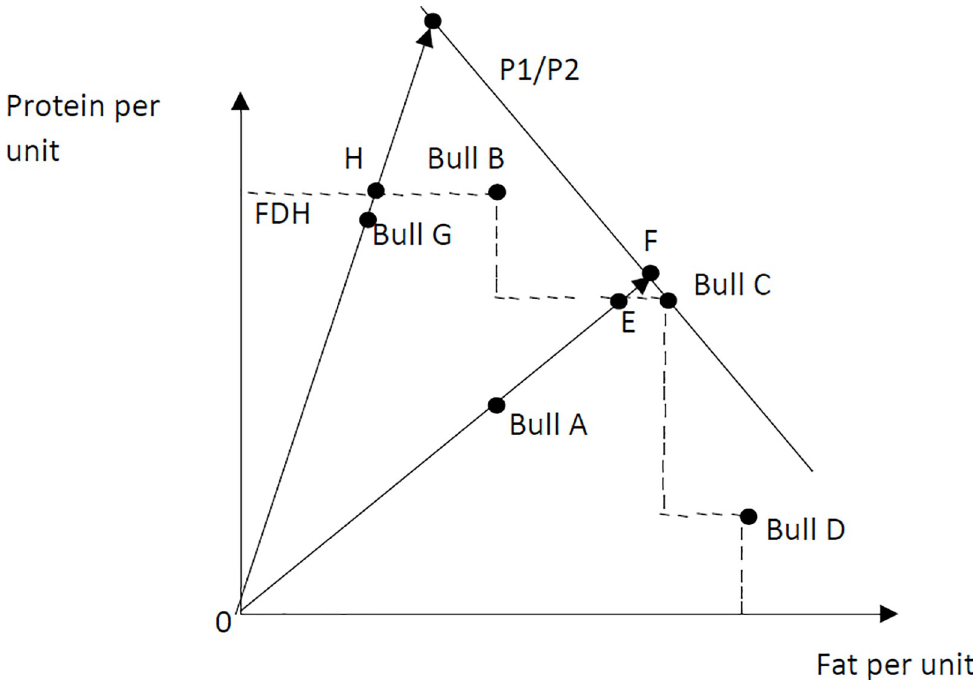
Fig 2. Graphical representation of Free Disposal Hull (FDH) with two outputs (protein and fat) and one input (semen).